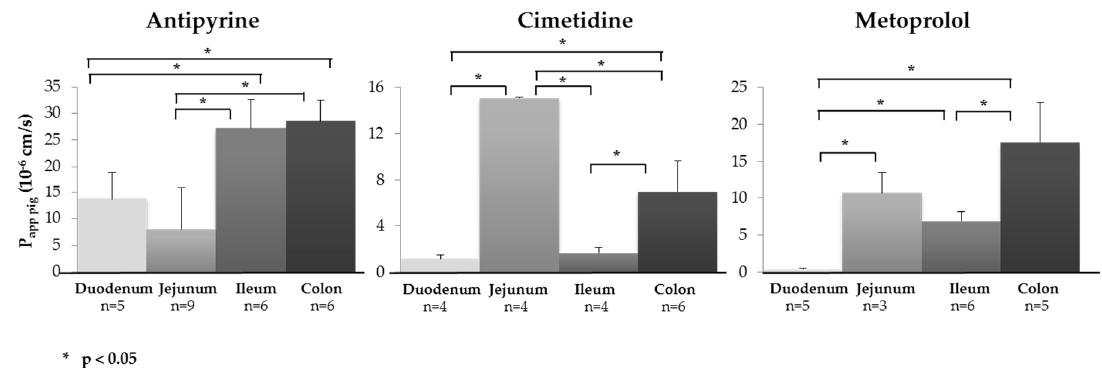
Figure 2. The porcine ex vivo model was able to identify regional variations in intestinal absorption ( P app,pig ) for metoprolol, cimetidine and antipyrine in the duodenum, jejunum, ileum and colon. A 100 µM solution of each drug was prepared in KBR (Mean ± SD; n = number of replicates). A statistical analysis was performed using one-way ANOVA followed by a Bonferroni’s multiple comparisons ad hoc test.